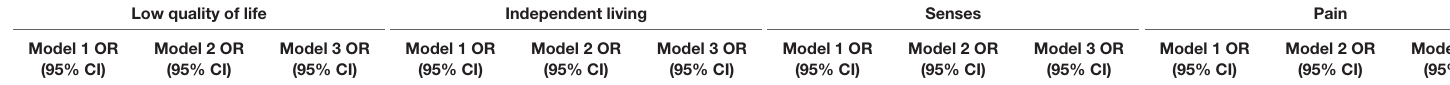
TABLE 6 | Multiple logistic regression analysis of the association of the presence of ARHL and/or tinnitus with high quality of life (low scores) and low subscores of domain-specific quality of